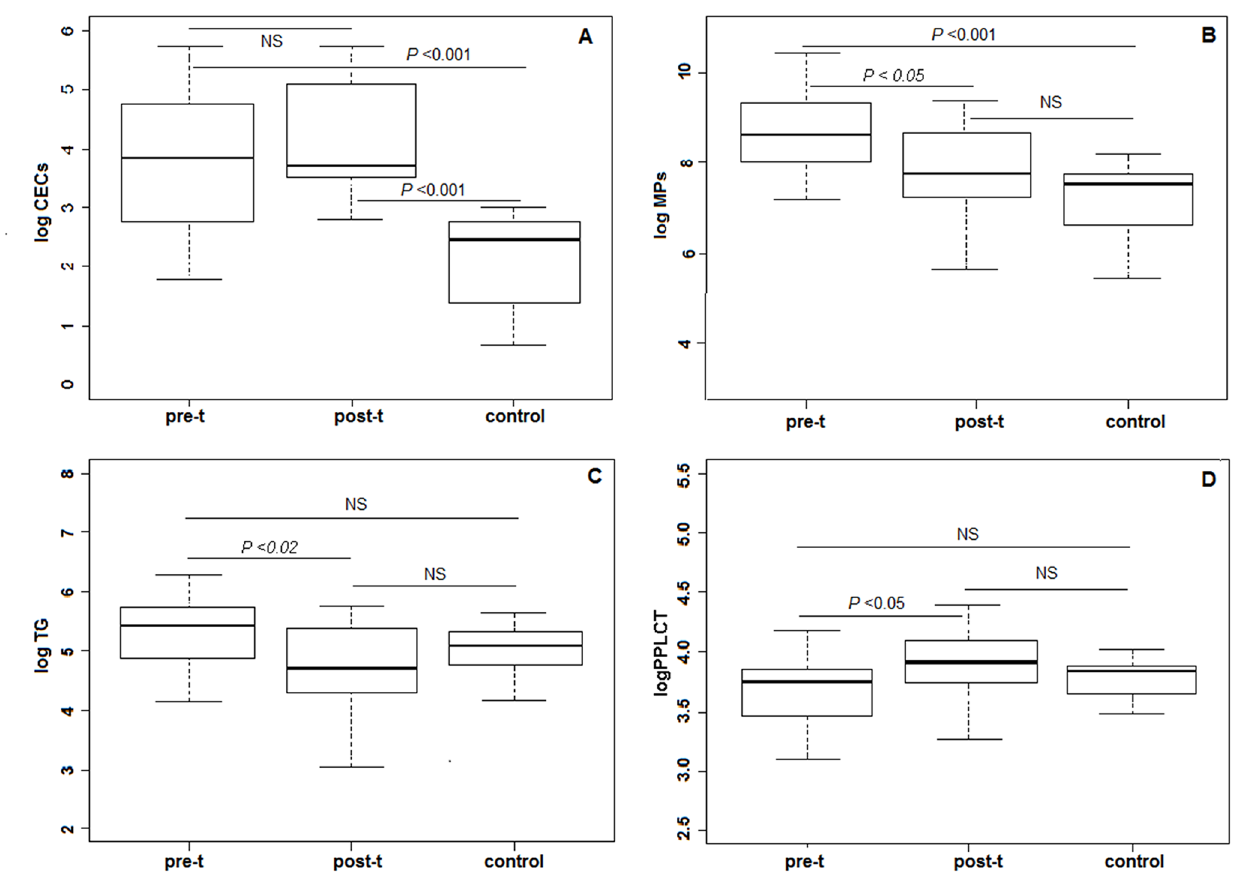
Figure 1. Pre- and posttreatment levels of biomarkers in patients and in controls. A: Circulating endothelial cells (CECs), B: Microparticles (MPs), C: Endogen thrombin generation (TG); D: Procoagulant phospholipid-dependent clotting time (PPLCT). Marker levels and their standard deviations are shown for pre-t: pretreatment; post-t: posttreatment; c: controls. Logarithmic transformation of data was made to normalize the distributions. NS: no significant.